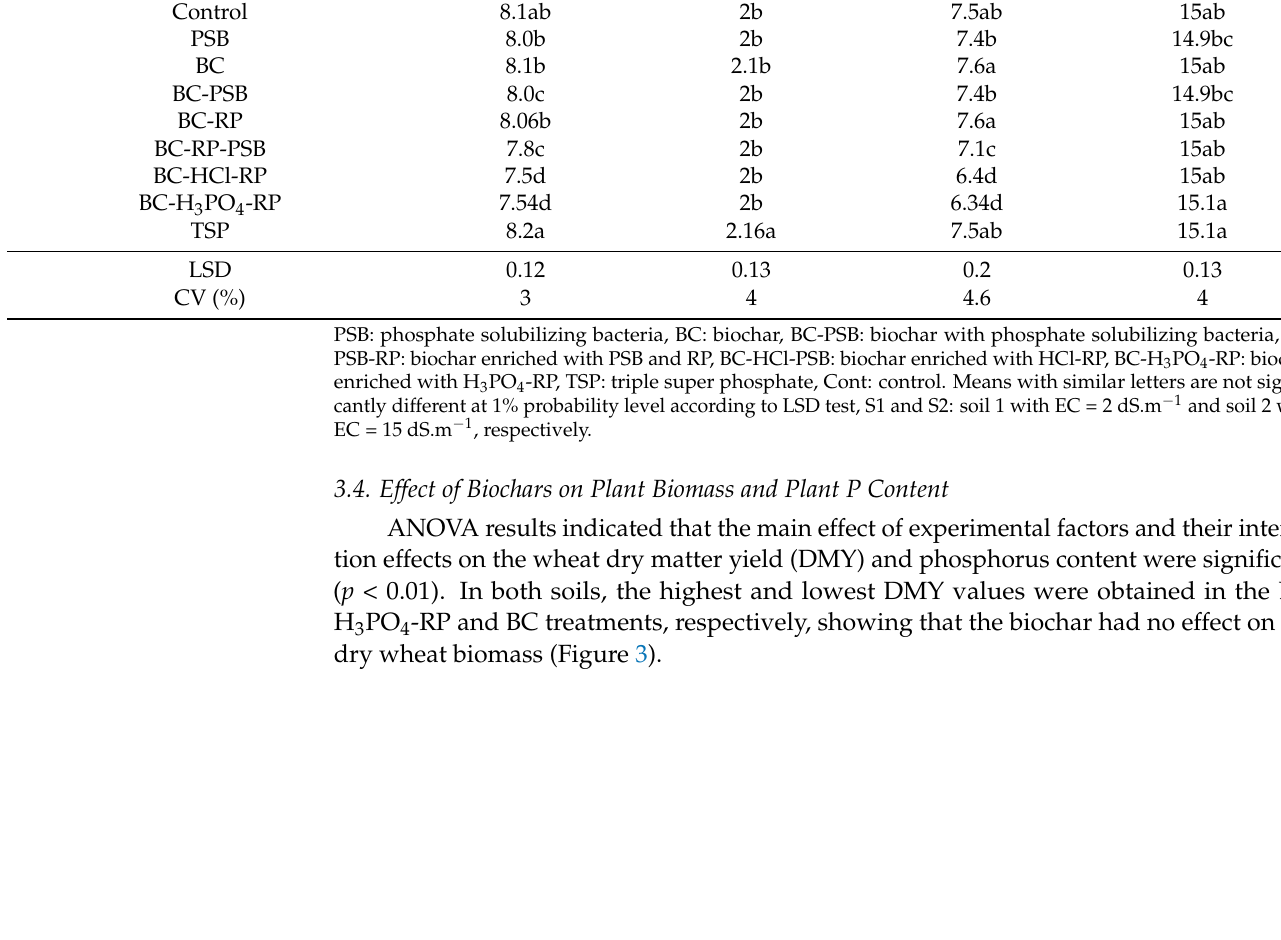
Table 7. E ff ect of treatments on soil pH during the incubation.